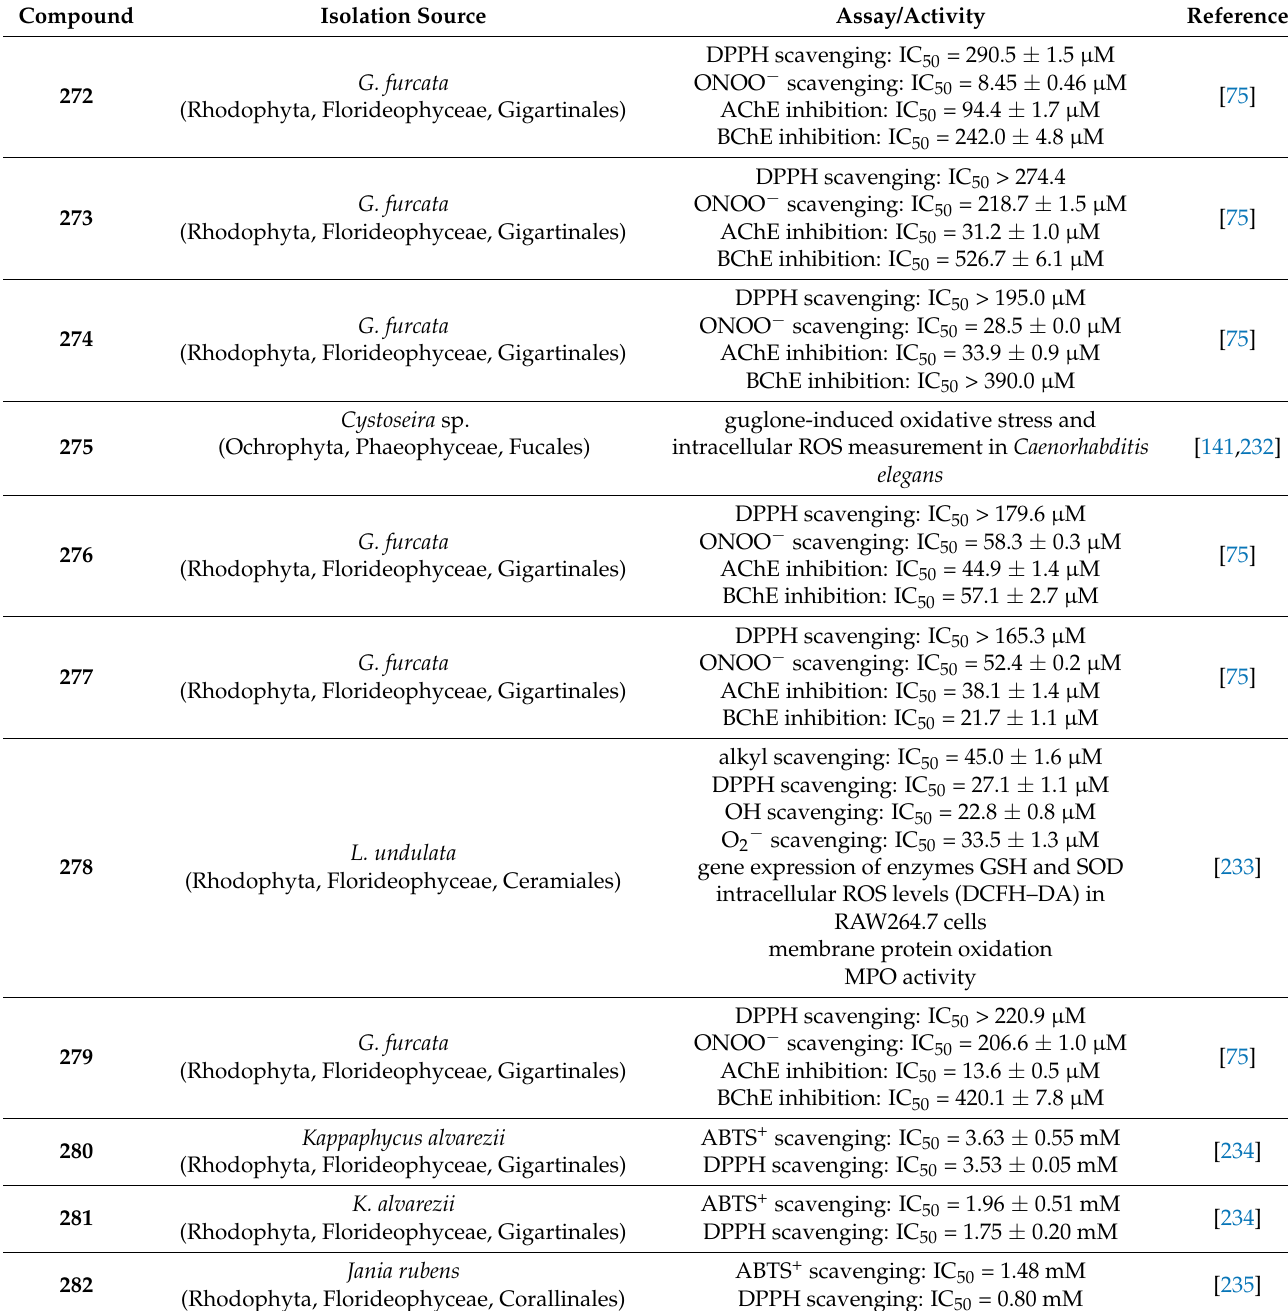
Table 7. Miscellaneous compounds from macroalgae with antioxidant